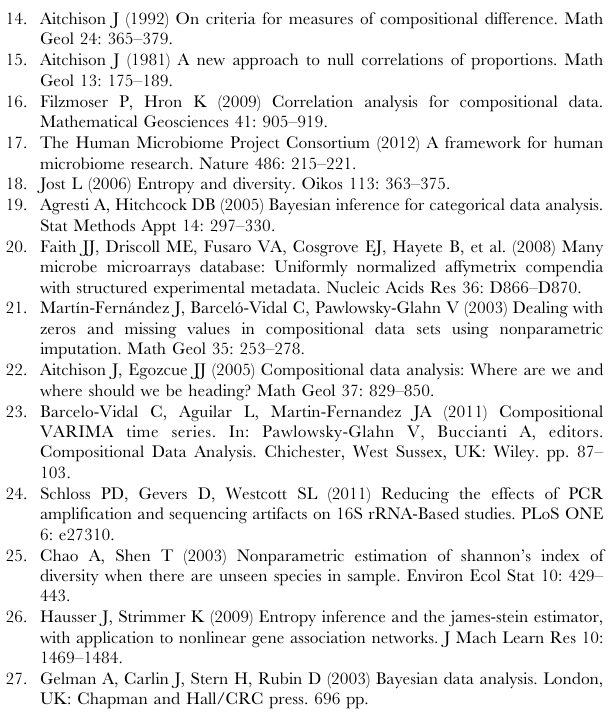
Figure S2 Spearman correlations inference quality deteriorates with decreasing diversity. Like Pearson correlations, Spearman correlations are also affected by the compositionally of the data and yield correlation networks that are only marginally more accurate than Pearson correlation networks (compare Fig. 2). Data simulation procedure and parameter values are identical to those used in Fig. 2. Figure S3 Root-mean-square error (RMSE) of both Spearman CLR inferred correlations. The accuracy of Spearman correlations (A) is comparable to that of Pearson correlations. CLR correlations (B) are more accurate than both Pearson and Spearman correlation, but not as accurate as SparCC correlations (compare Fig. 3). Note that the Spearman correlations estimated from the fractions were compared to the true basis Spearman correlations, rather than Pearson correlations. Data simulation procedure and parameter values are identical to those used in Fig. 3. Figure S4 CLR correlations are strongly biased when a small number of components is analyzed. RMSE of SparCC (A) and CLR (B) correlations for datasets composed of 5 components. Data is simulated as described in Materials and Methods section of main text.